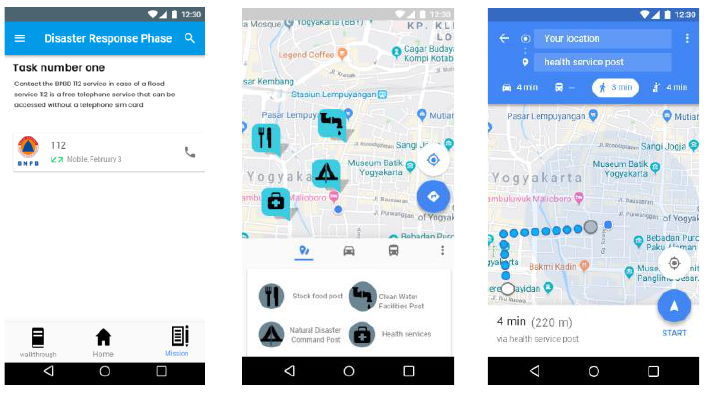
Fig. 4. Walkthrough menu for disaster response